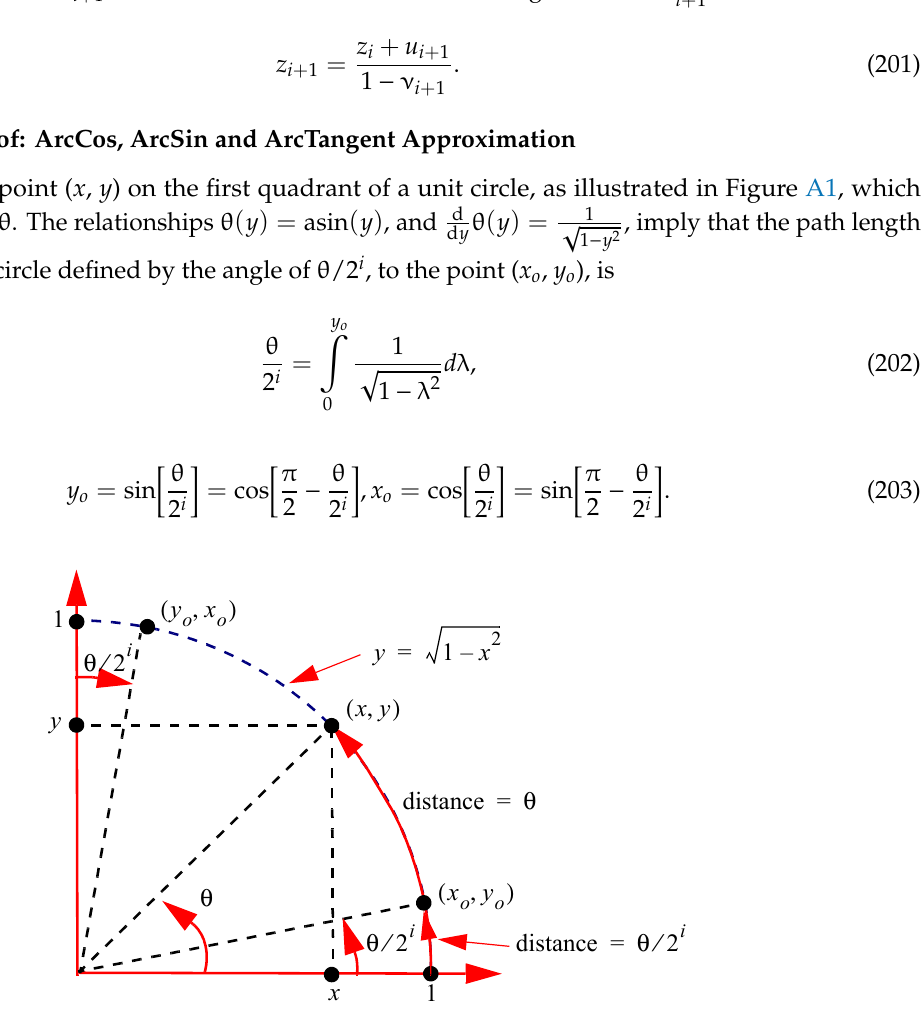
Figure 18. Geometry, based on the unit circle, for defining based on Figure A1. Geometry, based on the unit circle, for defining ( x